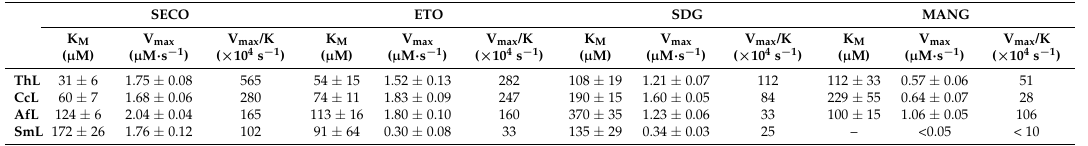
Table 1. The catalytic parameters of oxidation of the lignans.